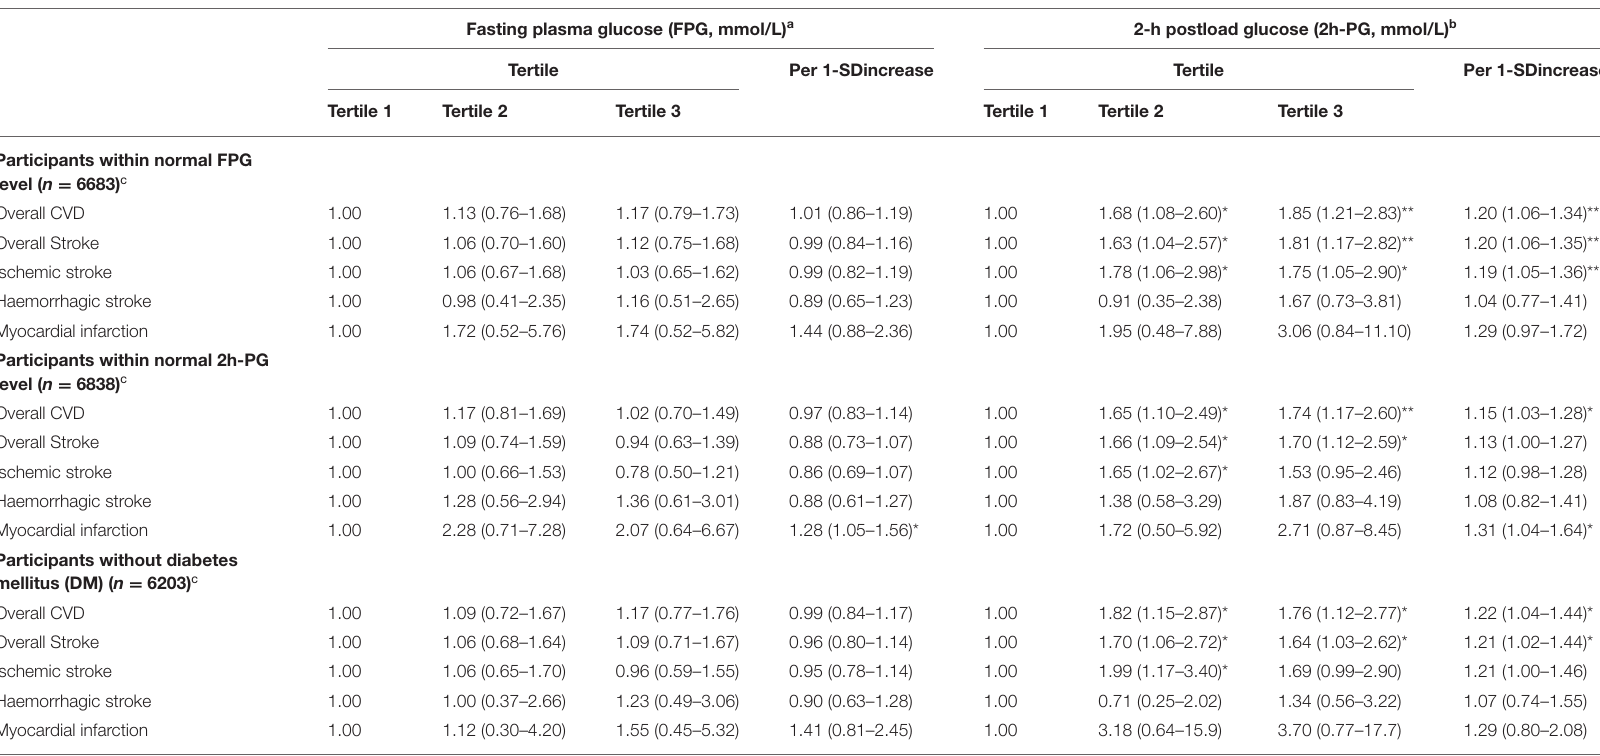
TABLE 3 | Hazard ratios (HRs) and 95% confidence intervals (95%CIs) for cardiovascular disease (CVD) associated with baseline fasting plasma glucose (FPG) and 2-h postload glucose (2h-PG) among participants within normal baseline blood glucose level or free of diabetes mellitus (DM). Fasting plasma glucose (FPG, mmol/L)